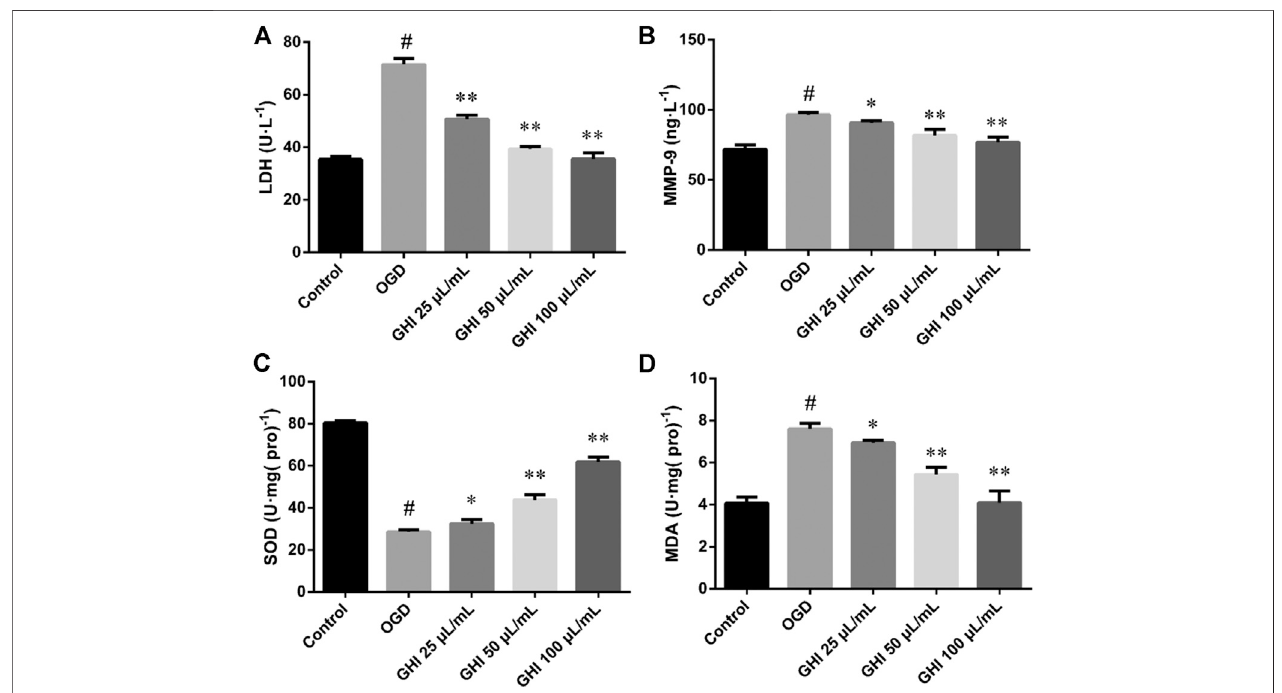
FIGURE 14 | Effects of GHI on the levels of LDH, MMP-9, SOD, and MDA in rBMECs after OGD-induced injury. The data were expressed as means ± SD (n (cid:2) 8). # p < 0.01 compared with the Control group; * p < 0.05, ** p < 0.01 compared with the OGD group.